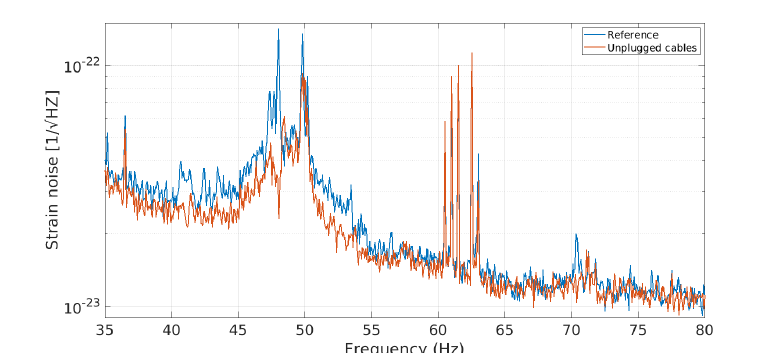
Figure 10. Test of unplugging west end (WE) mirror stepper motor crate cables: sensitivity curve before (blue) and after (red) the unplug of